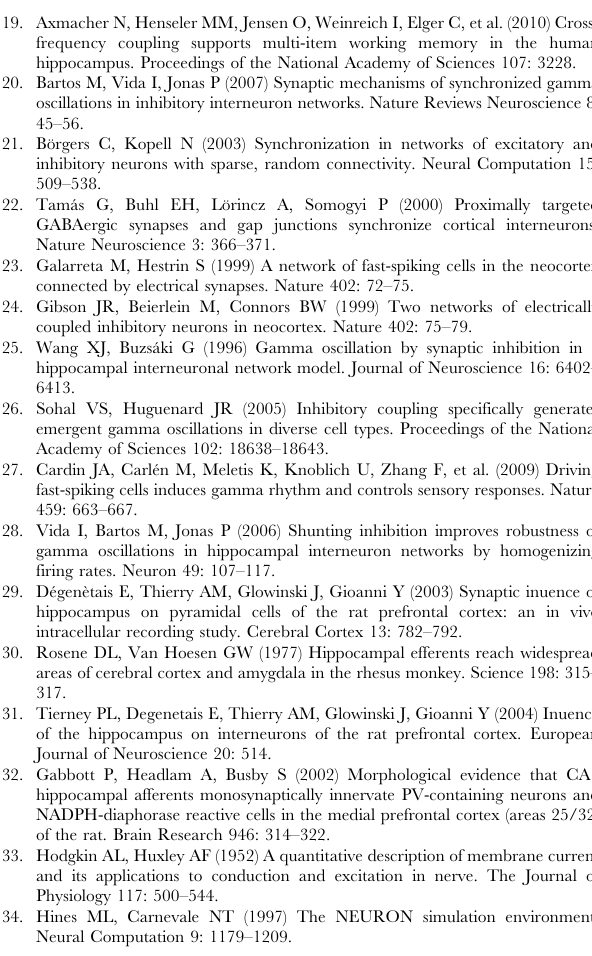
metric for the physiologically constrained parameters used in the original simulations. Figure S4 Correlations between the sinusoidal theta input signal, and the amplitude envelope of the LFP gamma oscillations, as a function of GABA-ergic synap- tic reversal potential. Since we know that GABA reversal potential greatly influences gamma synchrony in the interneurons, this parameter is here used as a proxy for manipulating gamma synchrony. Figure S5 Distributions of composite phase/amplitude values when using total postsynaptic current (right) versus membrane potential (left) as simulated LFP signal.